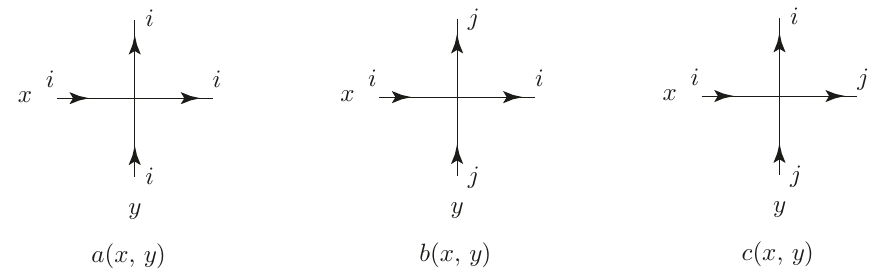
Figure 11 . The non-zero vertex (Boltzmann) weights w v ( x, y ) (whose values are given in (B.4) in the case of the rational models, and in (B.5) in the case of the trigonometric models) that can assigned to a vertex v . The arrows indicate the directions of rapidity and inhomogeneity parameter flows, and the integers i, j = 1 , . . . , M + 1, i 6 = j , are the state variables, or colours assigned to the